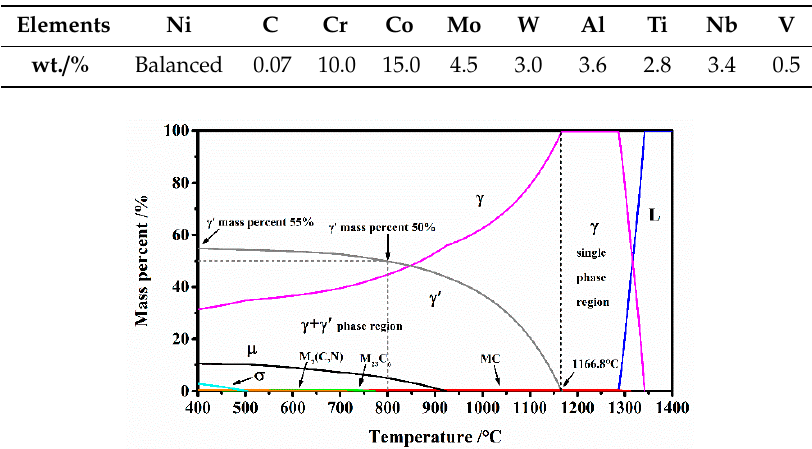
Table 1. Chemical compositions of the GH4151 superalloy (major elements).